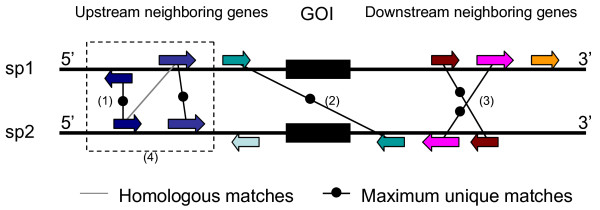
Diagram illustrating the computation of the maximum number of unique homologous matches. We counted the homologous matches between 3 neighboring genes (shown as filled arrows with corresponding gene orientations) on each side of the two genes of interest (GOI, shown as two black boxes). Homology between neighboring genes (shown as line between genes) is defined as Blastp E-value < 1e-5. The homologous matches do not need to be between the genes with the same orientations (1) or on the same strand (2). Also they do not need to be co-linear (3). When there are many-to-many homologous matches, we choose the maximum unique matches (4). The number of maximum unique homologous matches in this case is 5.